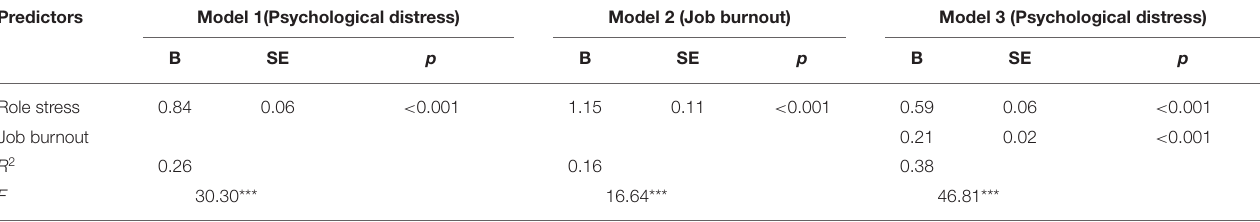
TABLE 2 | Testing the mediation effect of role stress on psychological distress through job burnout a .